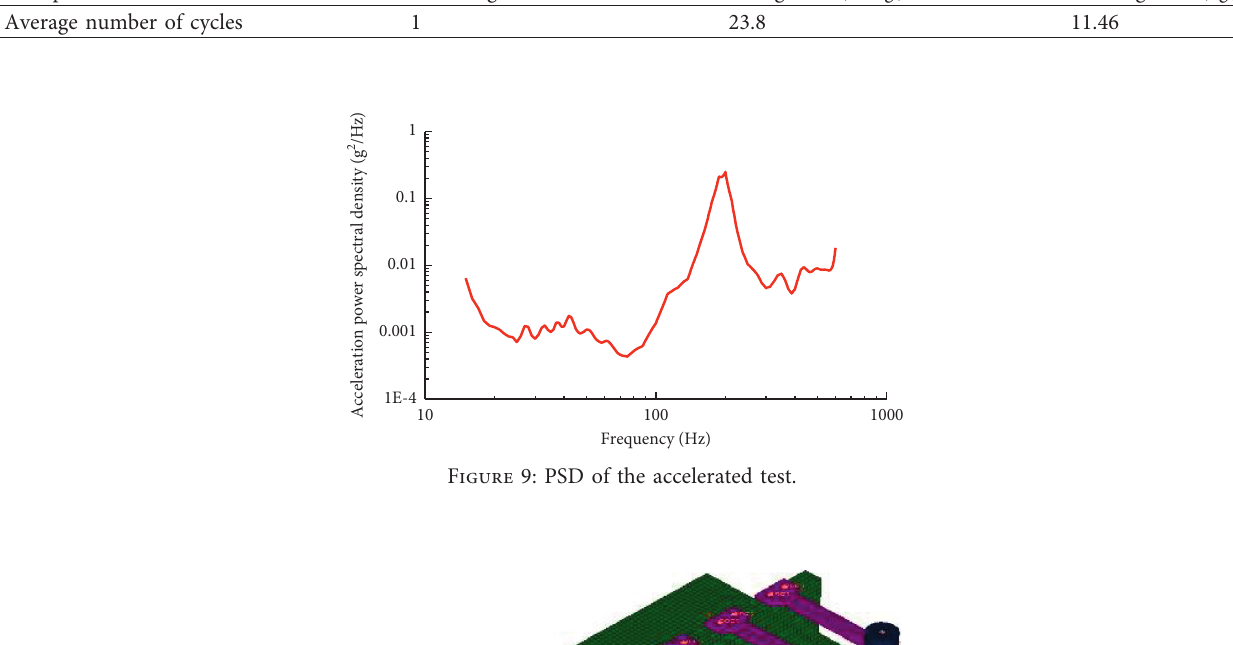
Table 2: Number of FDS cycles that represent the whole life of each mission segment